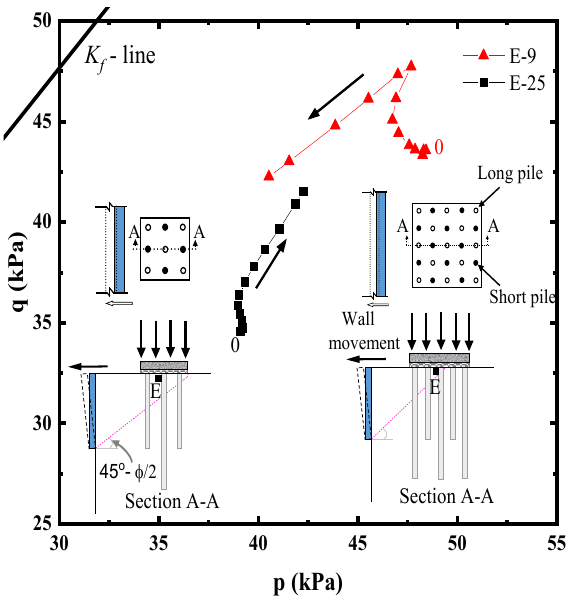
Figure 10: Stress paths experienced by soil element at the central composite foundation section for groups with 9 and 25 long-short CFG piles situated at 3 m behind the wall.